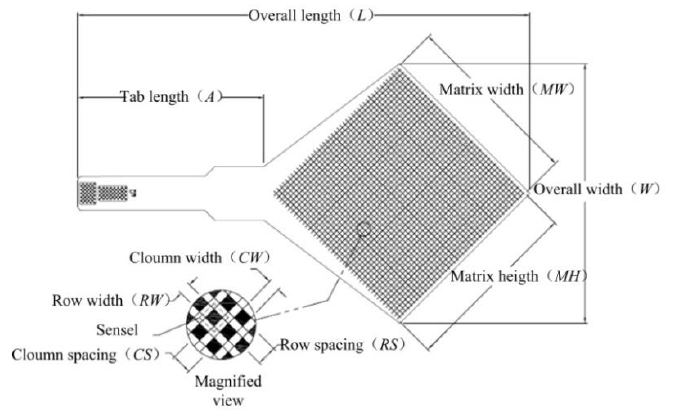
Figure 5. Structure diagram of the 5250 flexible thin-film-network tactile pressure sensor.